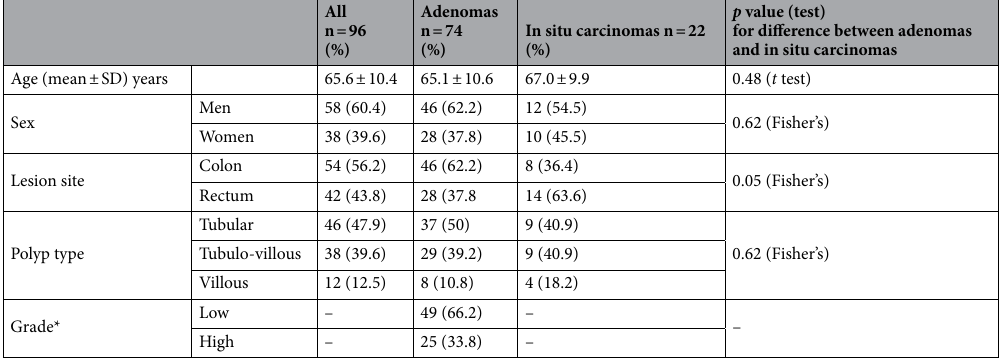
Table 1. Patient´s clinical characteristics. *For adenoma patients